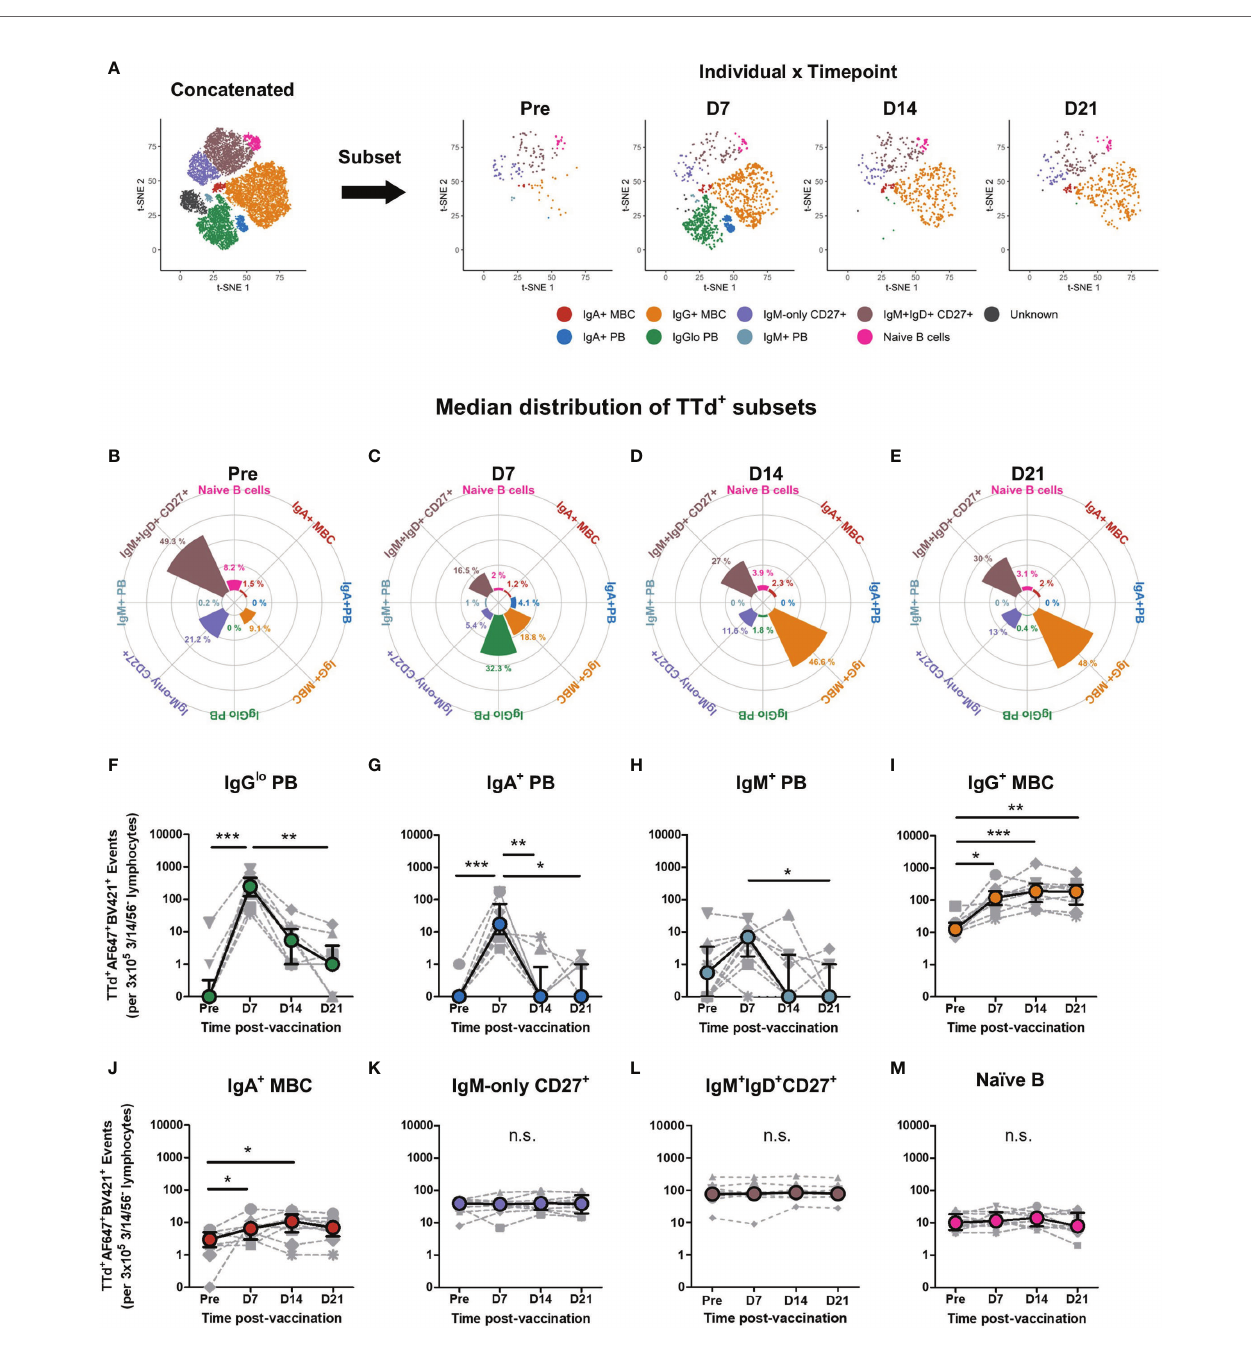
FIGURE 4 | Dynamic changes of TTd + B cell subsets following booster ADT vaccination in healthy adults. (A) From the concatenated data representing all TTd + events from 10 individuals at 4 timepoints, the concatenated t-SNE data set underwent data subsetting to examine TTd + events for each individual at each time point (as shown in representative plots of an individual at days 7, 14 and 21 post-ADT). (B – E) t-SNE subset distribution (%median proportions) for each timepoint are shown as rose plots. (F – M) Median frequencies (events) of each t-SNE-de fi ned subset are shown. (*, ** and *** denote p < 0.05, 0.005 and 0.0005, respectively). n.s., not signi fi